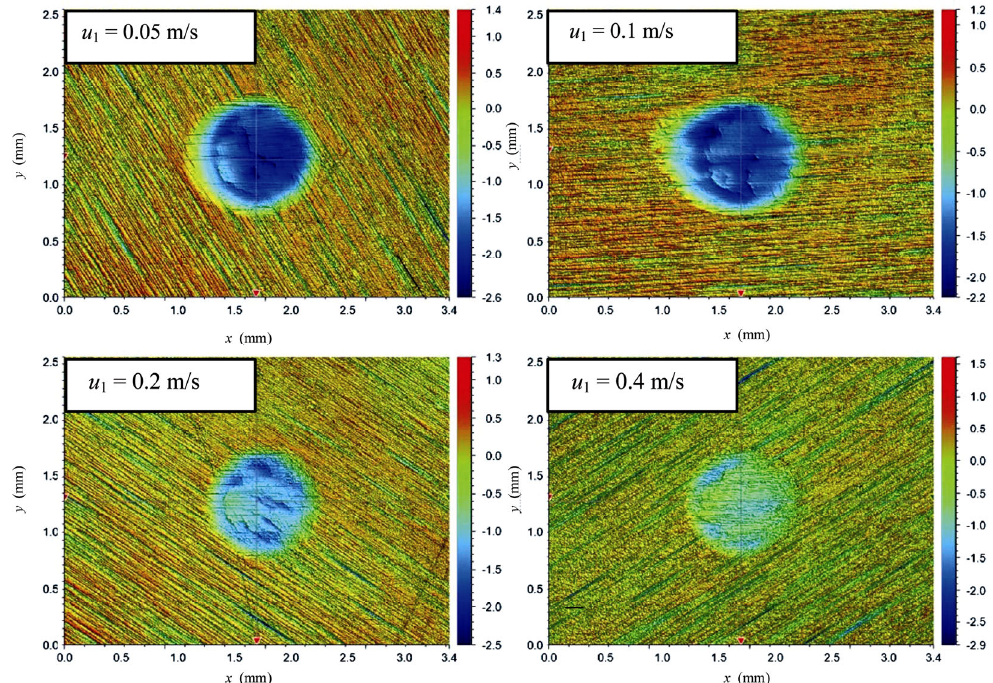
Fig. 9 Disk surfaces after wear at different